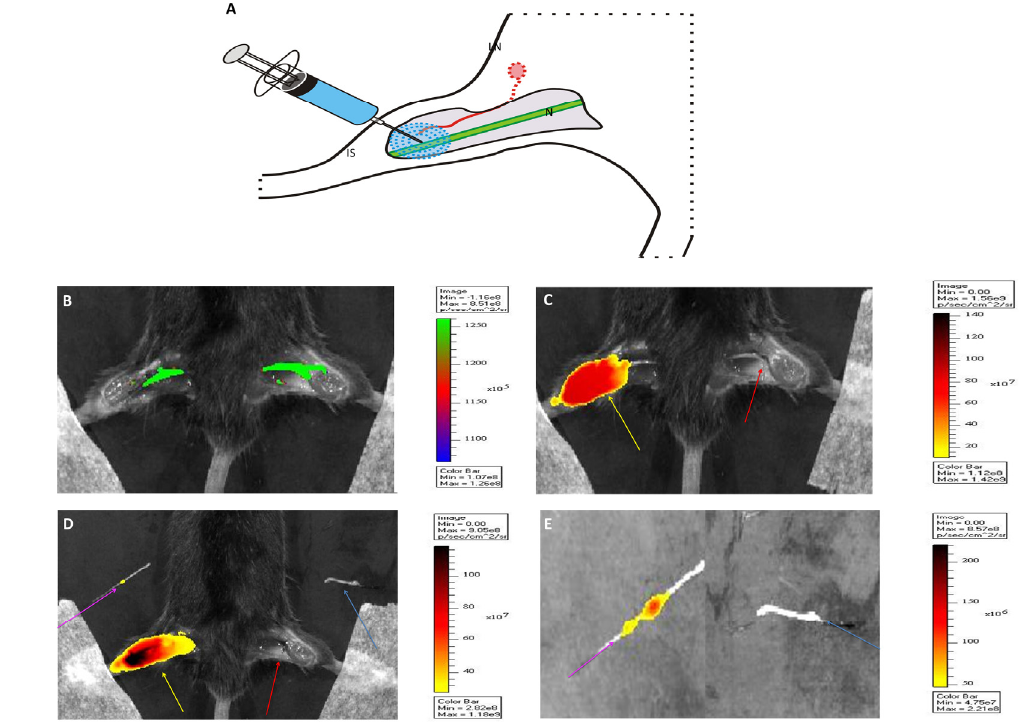
Figure 3. In vivo distribution of locally injected lectins ( A ) Schematic representation of the local injection of Cy5-lectins and the corresponding migration path. The injection site (IS) and sciatic nerve (N) are depicted in blue and green respectively. The lymphatic tract leading from the IS to the lymph node (LN) is shown in red. ( B ) Illustration of the YFP signal in the nerves (green) which served as control for the localization of the nerves. Representative images of the injection site before ( C ) and after ( D ) removal of the nerve, and excised nerves ( E ). In each of these pictures, yellow arrows -the injection site; purple arrows -fluorescence signal from injection site and nerve, red arrows -the control side nerve and light blue arrows -the control